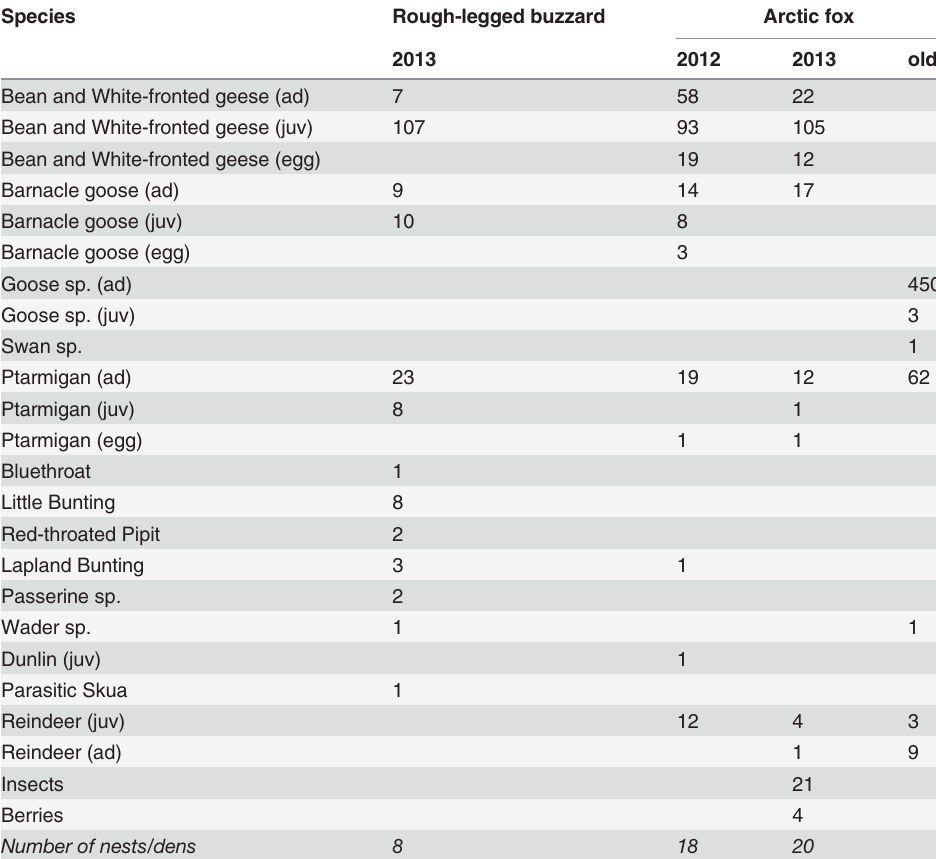
Table 1. Number of identi fi ed prey items of Rough-legged buzzard and Arctic fox collected on the dens/nests on the Kolguev Island, Russia. Species Rough-legged buzzard Arctic fox 2013 2012 2013 old Bean and White-fronted geese (ad) 7 58 22 Bean and White-fronted geese (juv) 107 93 105 Bean and White-fronted geese (egg) 19 12 Barnacle goose (ad) 9 14 17 Barnacle goose (juv) 10 8 Barnacle goose (egg) 3 Goose sp. (ad) 450 Goose sp. (juv) 3 Swan sp. 1 Ptarmigan (ad) 23 19 12 62 Ptarmigan (juv) 8 1 Ptarmigan (egg) 1 1 Bluethroat 1 Little Bunting 8 Red-throated Pipit 2 Lapland Bunting 3 1 Passerine sp. 2 Wader sp. 1 1 Dunlin (juv) 1 Parasitic Skua 1 Reindeer (juv) 12 4 3 Reindeer (ad) 1 9 Insects 21 Berries 4 Number of nests/dens 8 18